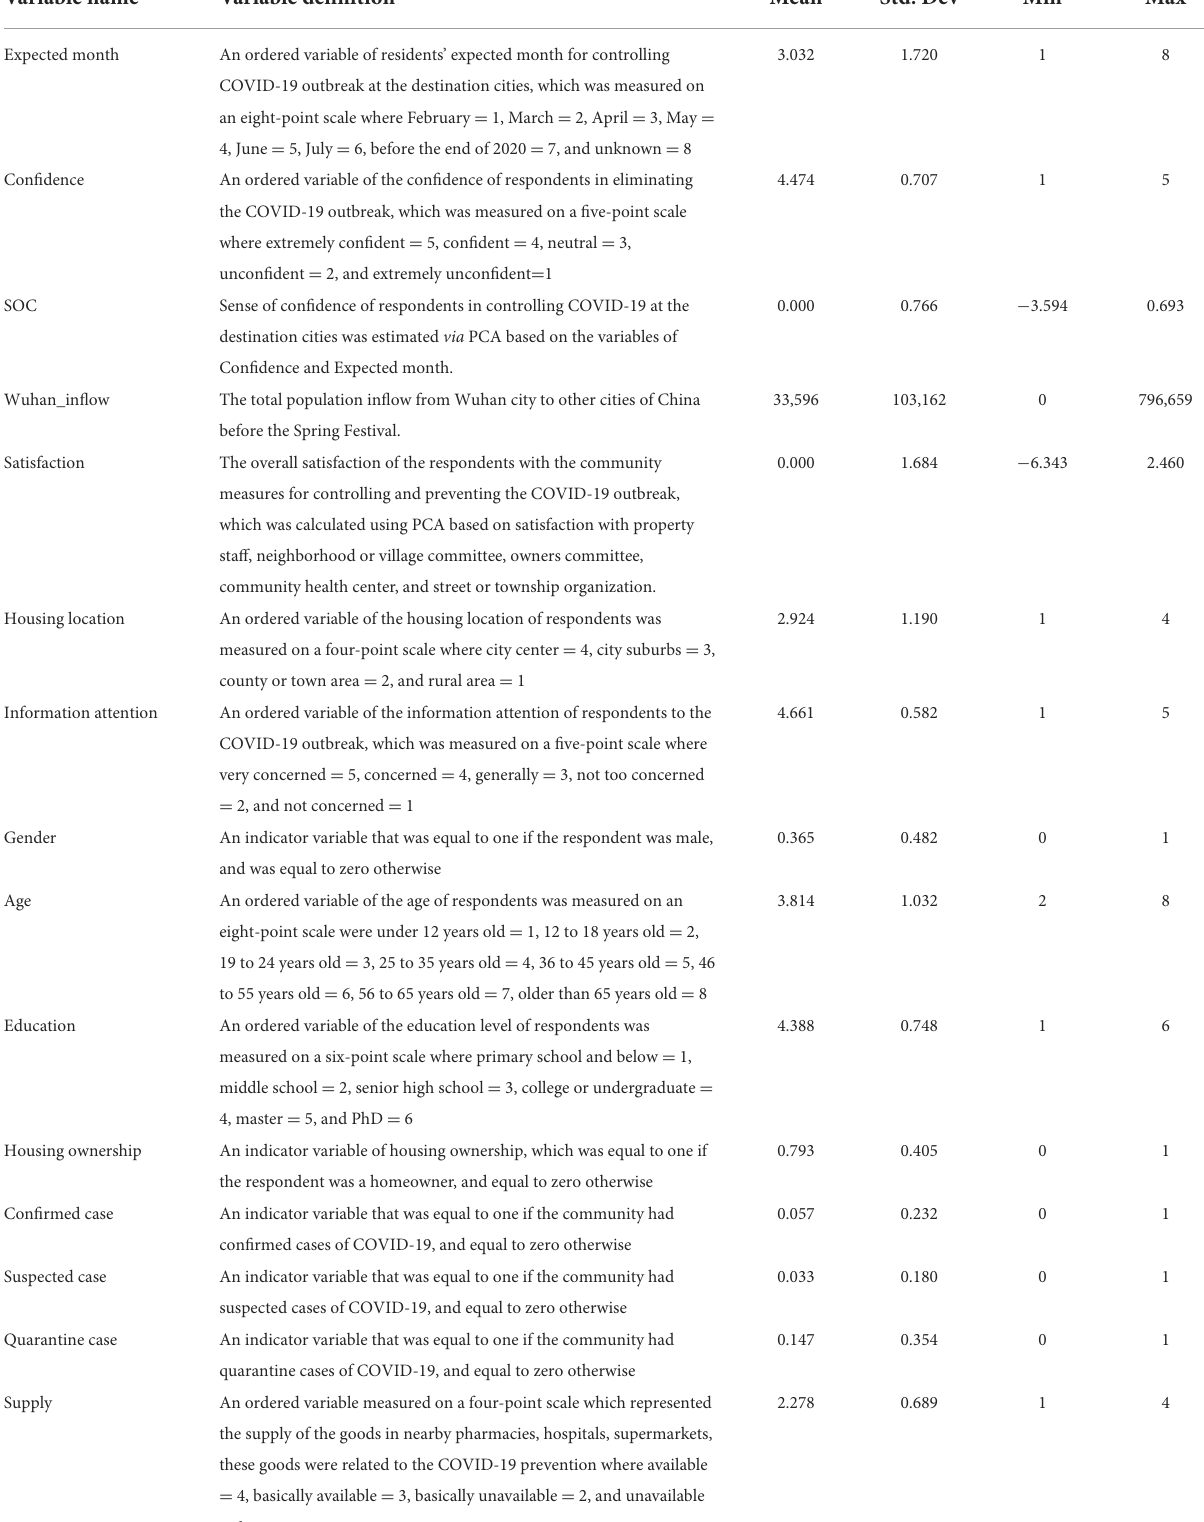
TABLE 2 Definitions and descriptive statistics of key